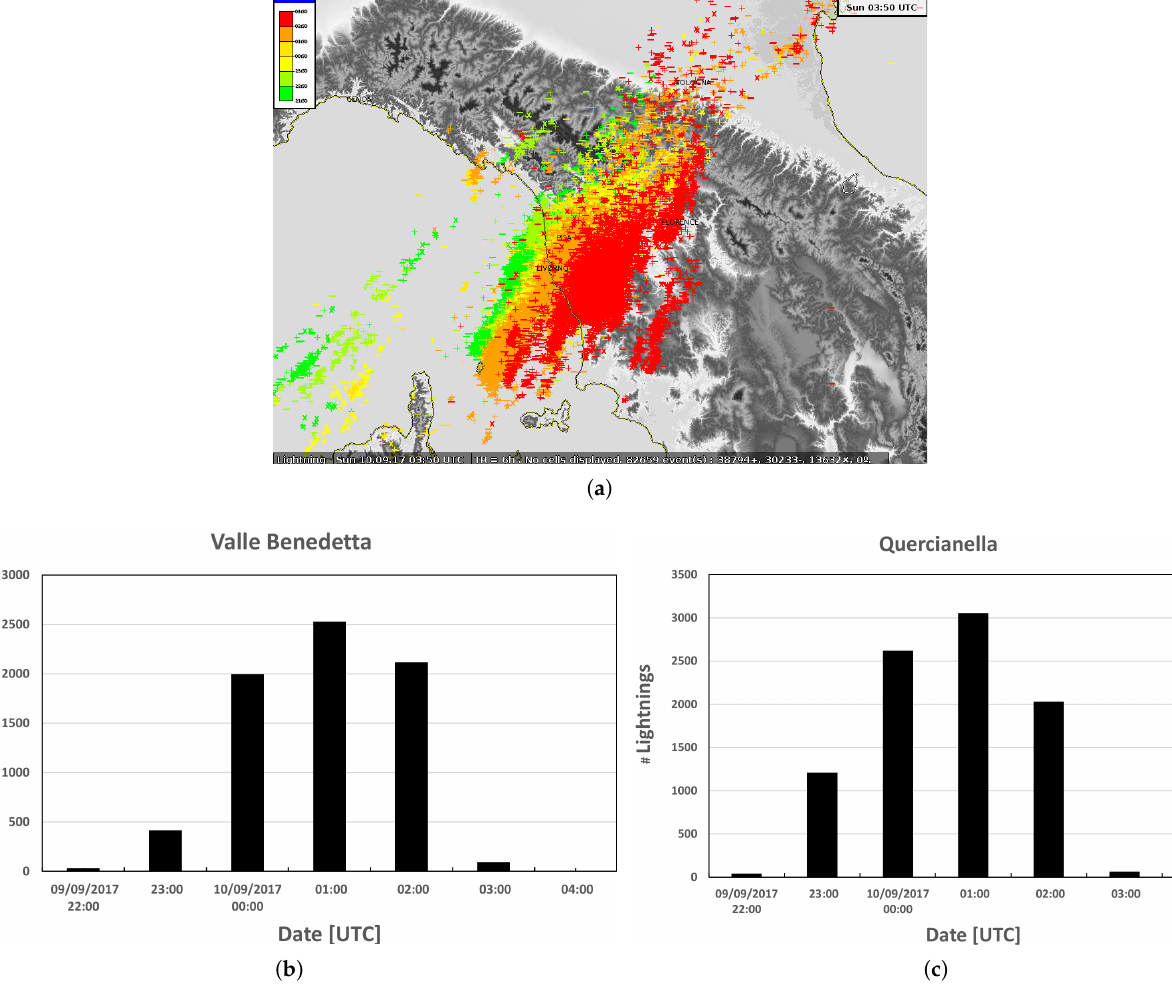
Figure 4. ( a ) Map of lightning strikes measured between 2150 UTC, 9 September 2017, and 0350 UTC, 10 September 2017. ( b ) A histogram of the number of strokes per hour within ± 0.1 degree of the Valle Benedetta rain gauge, registered from 2200 UTC, 9 September, to 0400 UTC, 10 September, 2017. ( c ) As in ( b ) but for the Quercianella rain gauge. Data were taken from the Blitzortung dataset (www.blitzortung.org/, (accessed on 29 April